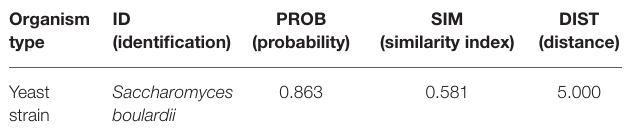
TABLE 2 | Microorganism identification with BIOLOG TM system.